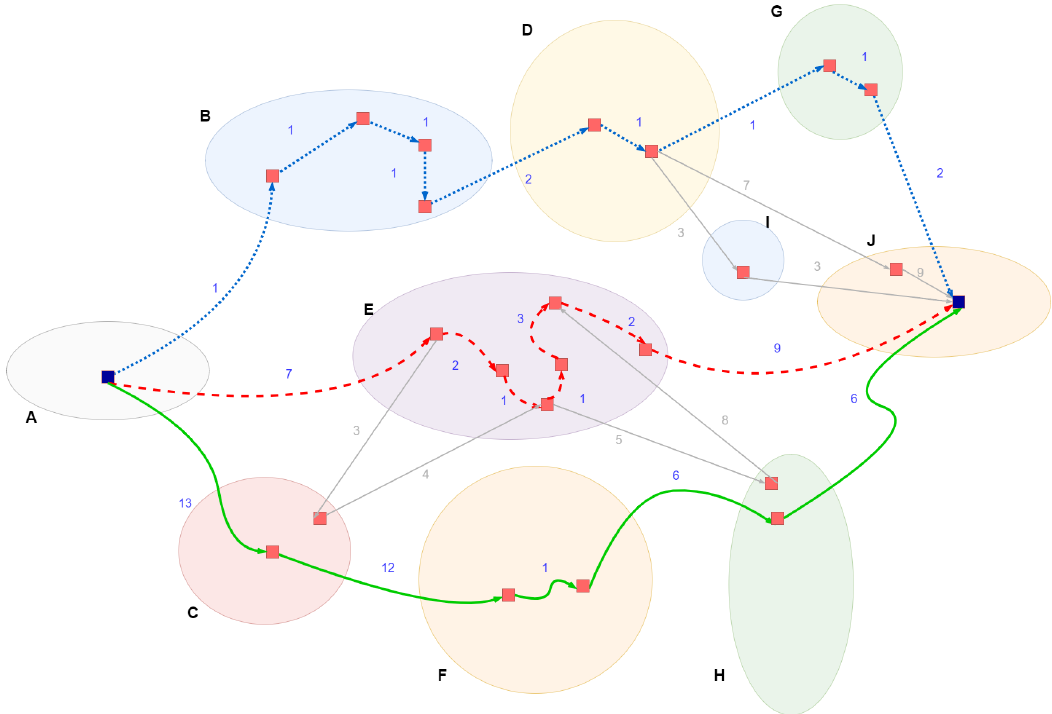
Figure 11. Paths that could be selected based on the Routing